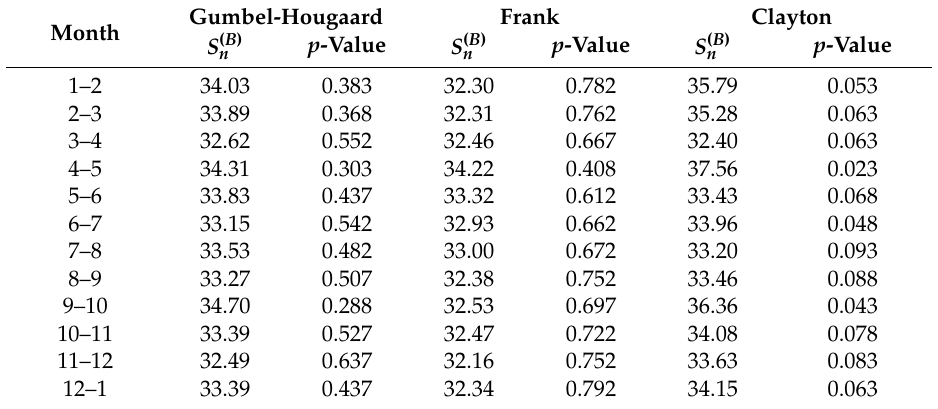
Table 3. Comparison of Cram é r von Mises statistic for joint distribution of different streamflow pairs. Gumbel-Hougaard Frank Clayton Month